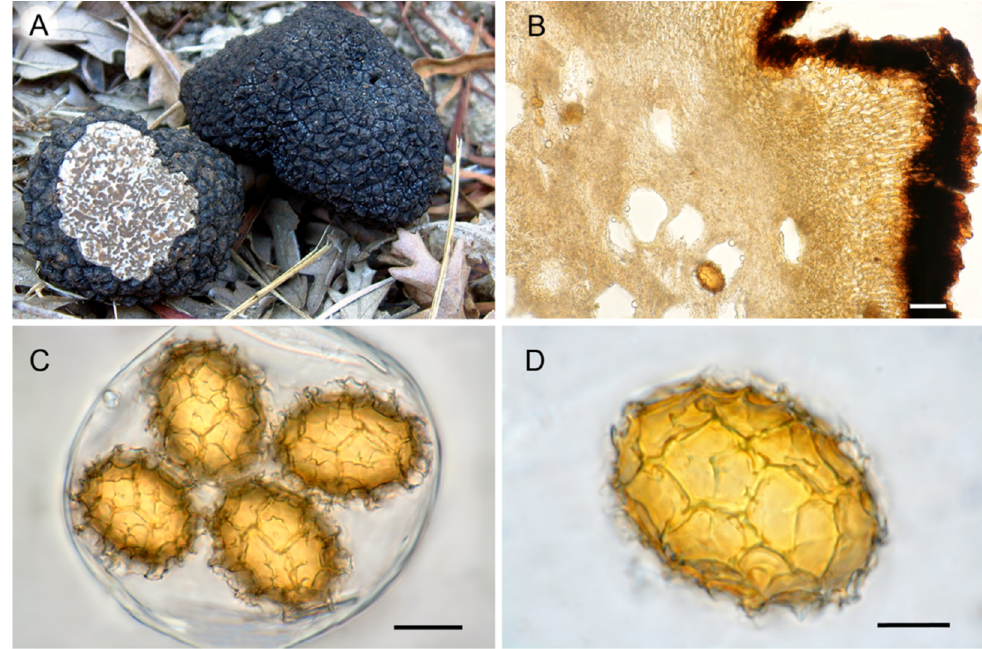
Figure 6. T. suave sp. nov. ( A ) Ascoma in section (holotype). ( B ) Peridium structure. ( C ) Asci and ascospores. ( D ) Ascospore. Bars = 50 µm ( B ), 20 µm ( C ), 10 µm ( D ).